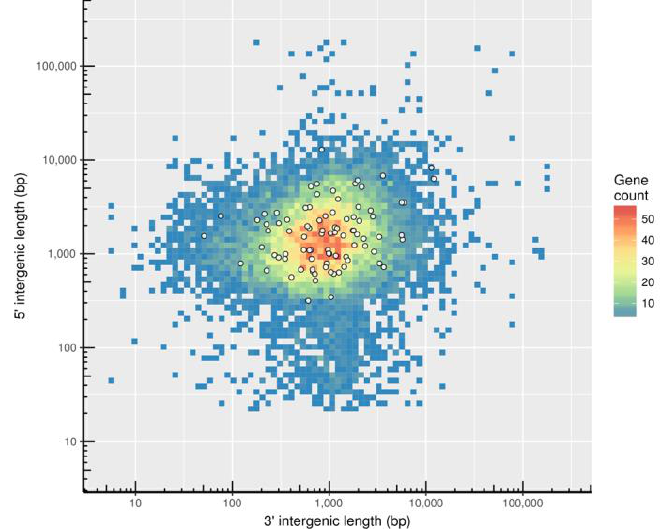
Figure 2 . Estimated intergenic distances between the predicted genes of the ESM15 genome. Density of genes for each pair of distances (3’ and 5’ intergenic distances) is given according to the legend on the right. White circles are the candidate secreted effector-proteins predicted (CSEP) using the combined predictions with a likelihood greater than 0.5, of EffectorP (Sperschneider et al. 2018) and SignalP (Armenteros et al.